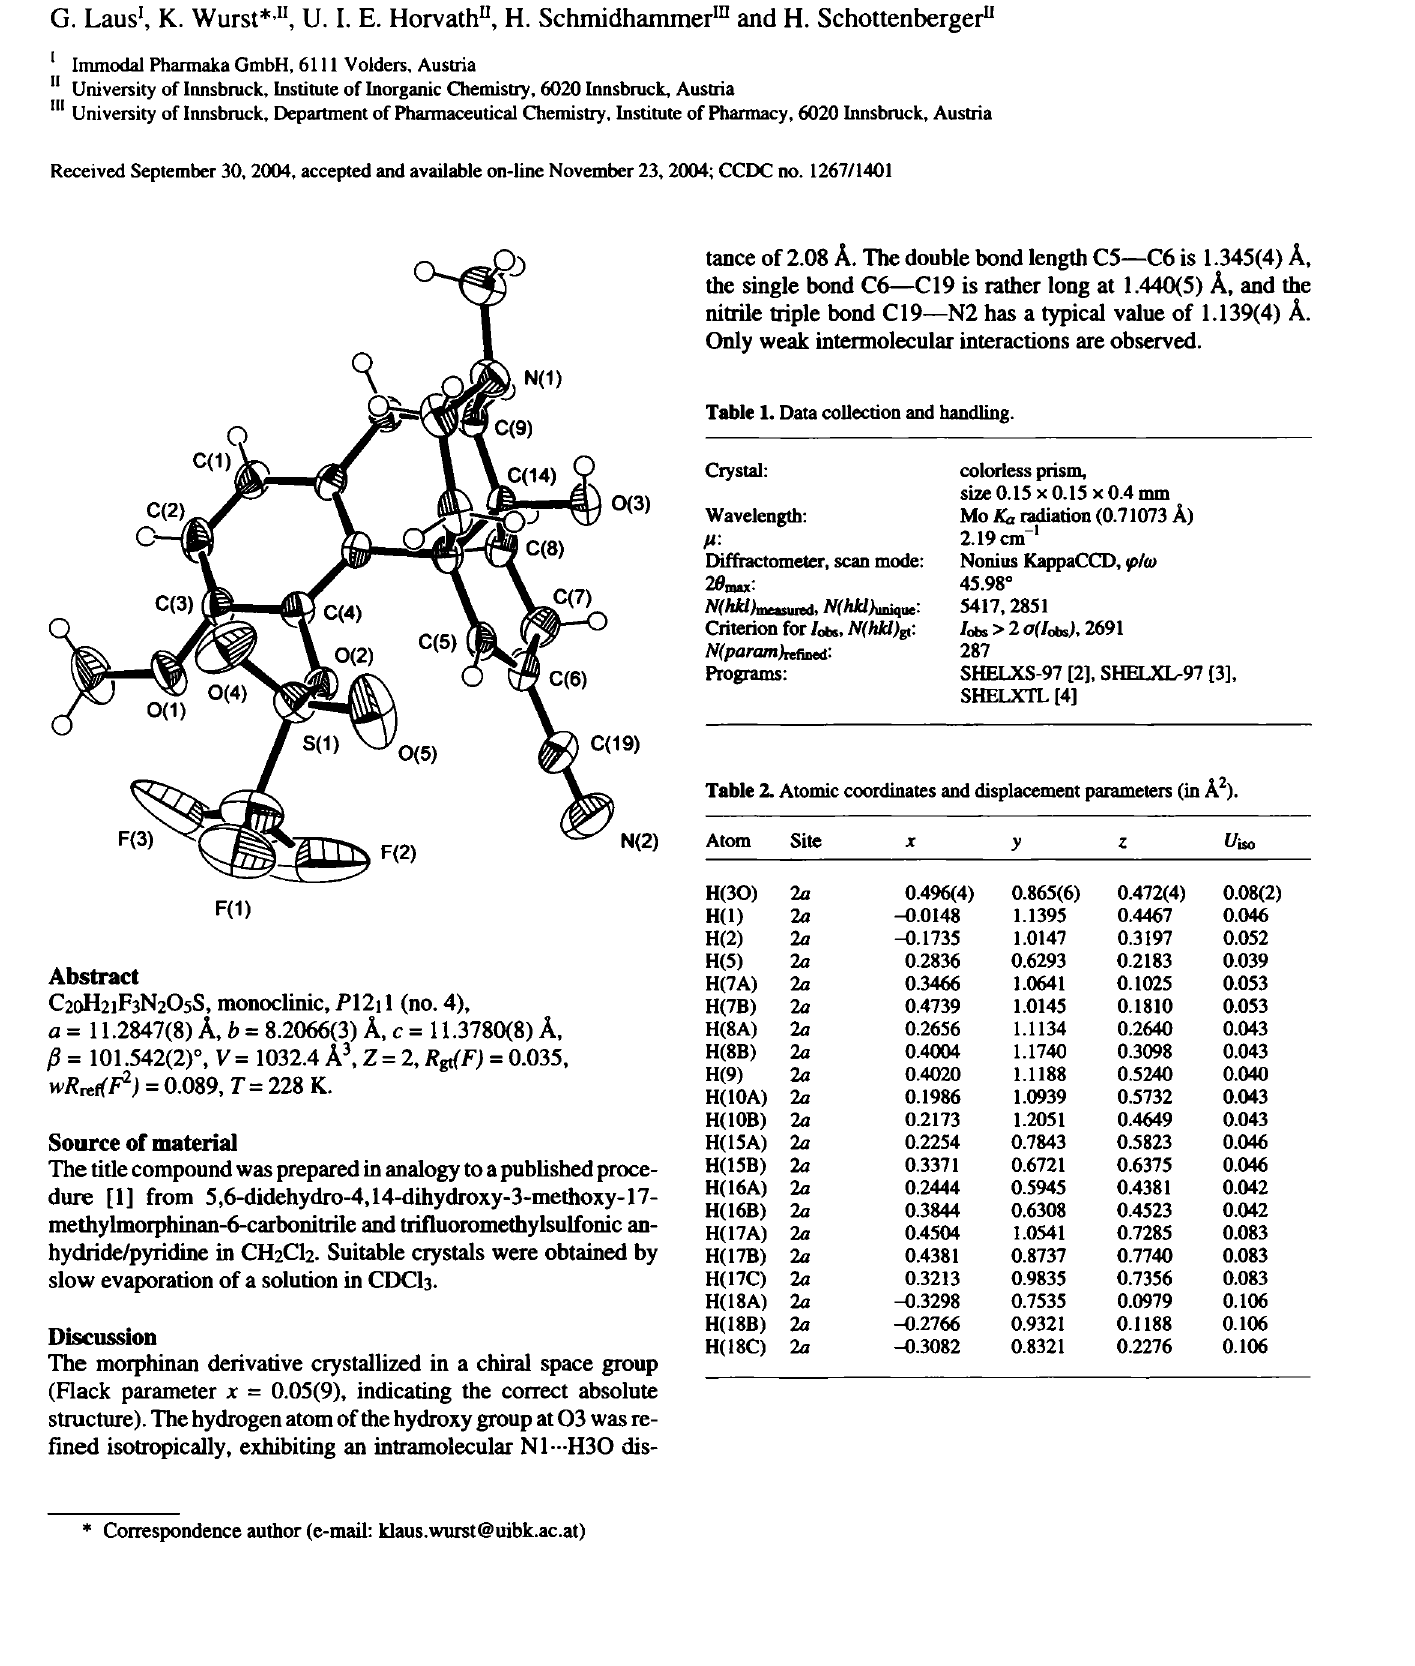
Table 1. Data collection and handling.